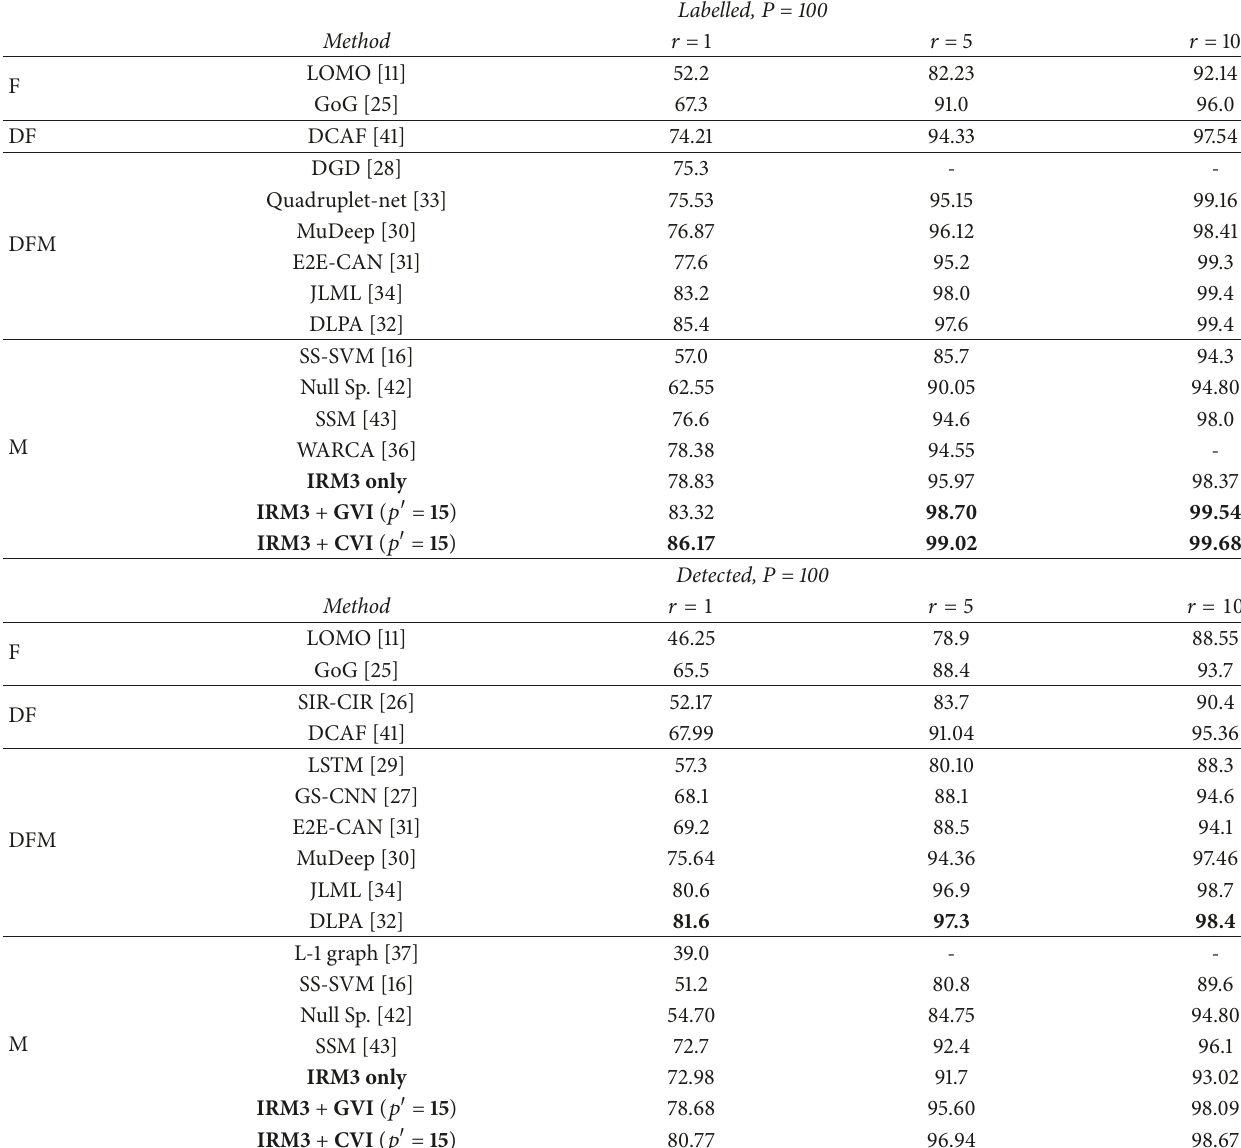
Table 3: Top matching comparison on